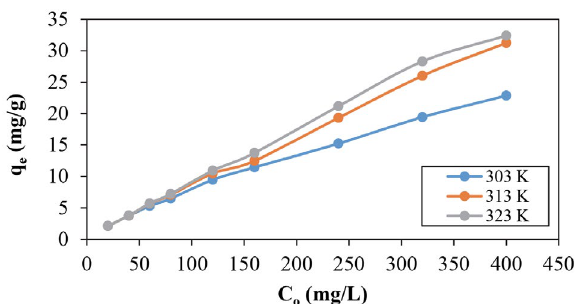
Fig. 11. Impact of temperature on the adsorption of Acid Violet 17 onto